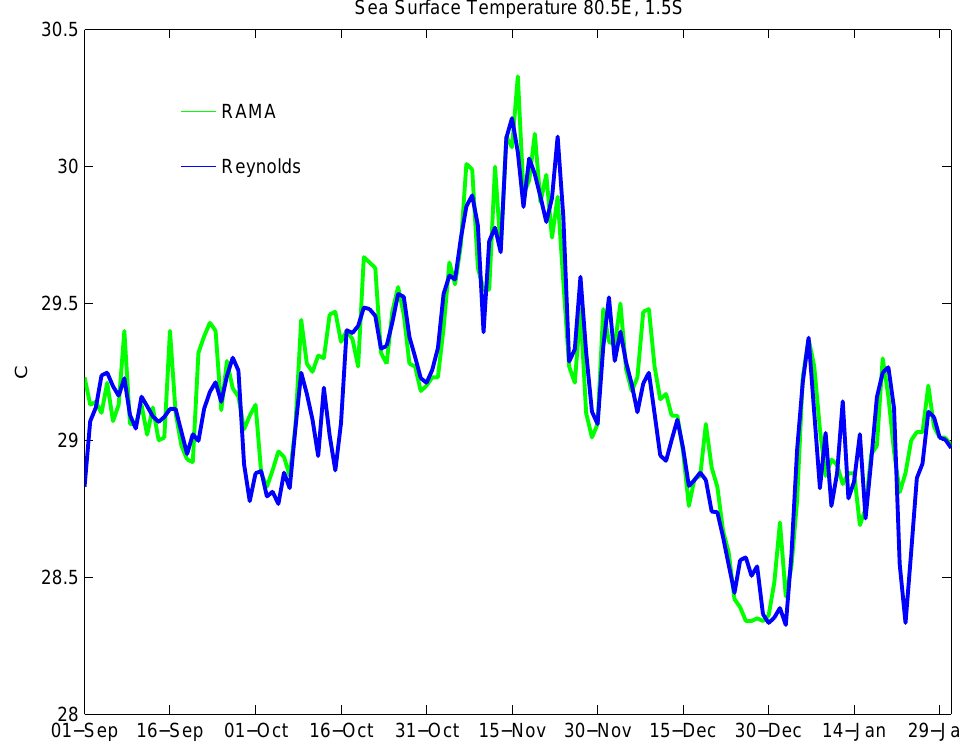
Figure 7. Time series of sea surface temperature (SST) from the RAMA buoy (green line) and from the SST analysis [20] (blue line).